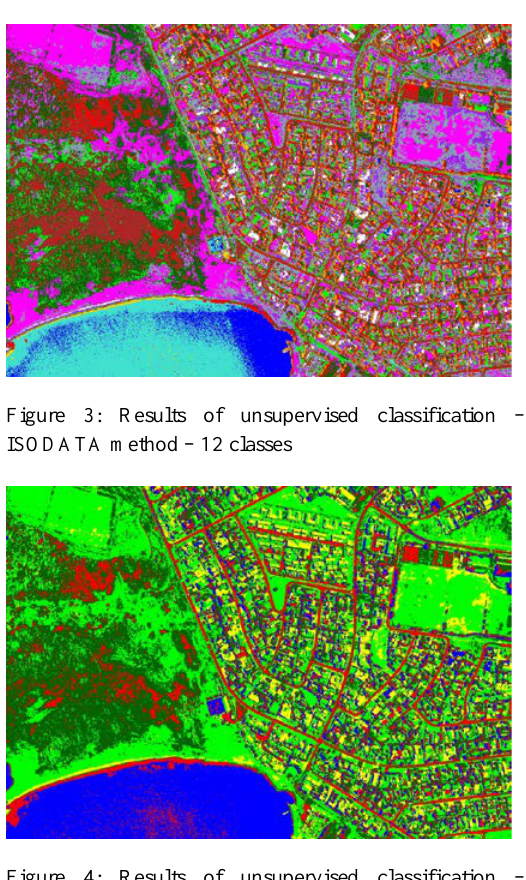
Figure 4: Results of unsupervised classification – ISODATA method – 5